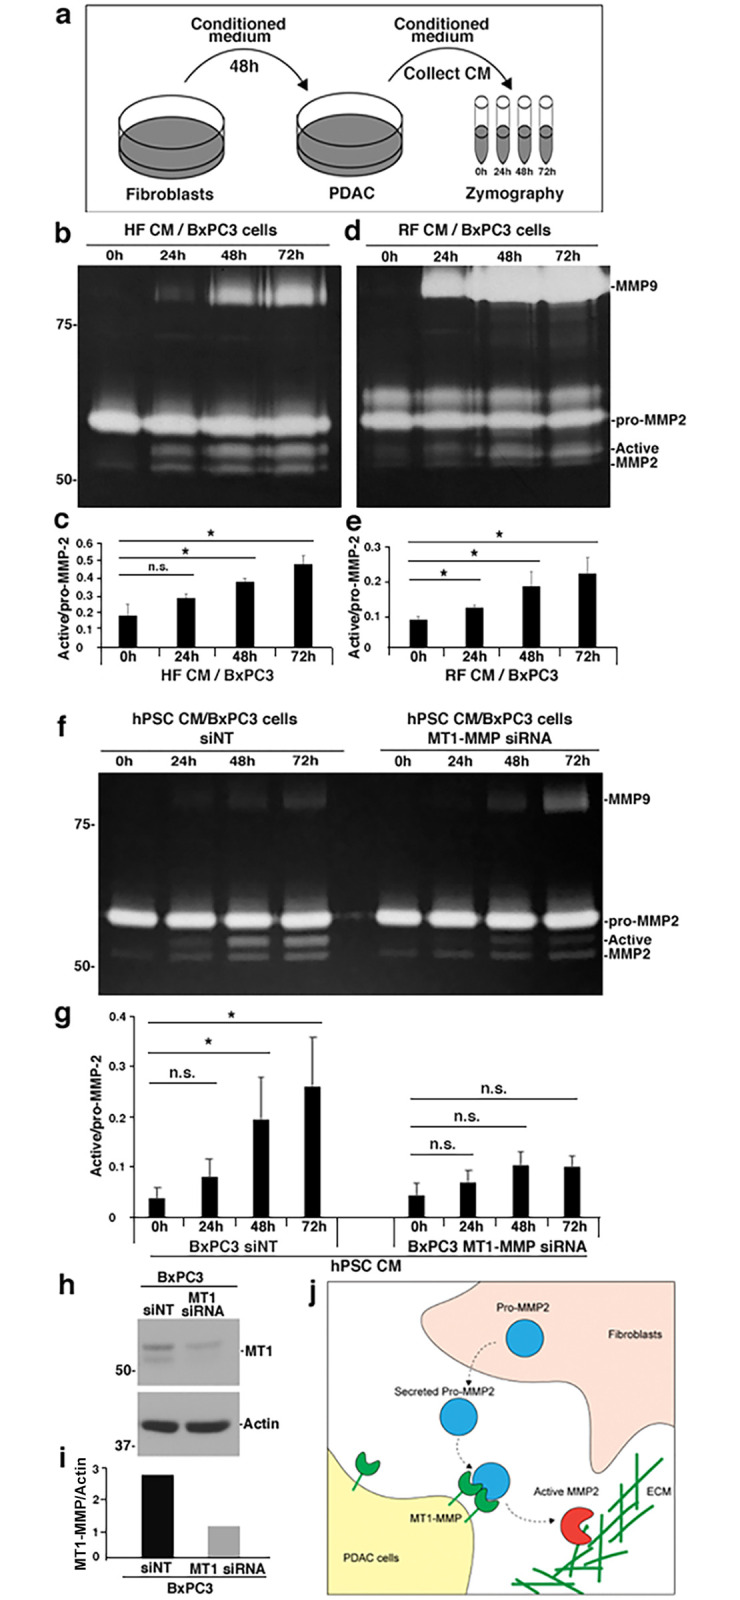
MMP2 secreted from stromal cells is activated by PDAC cell MT1-MMP.(a) An illustration of the experimental design followed for this experimental approach. CM from HFs, RFs, or hPSCs was collected and applied to BxPC3 cells. Subsequently, CM from the PDAC cell cultures was collected after 0, 24, 48 or 72 h and subjected to zymography. (b,d) Representative zymograms showing MMP2 activity of the CM described above. The activity of this protease from the HF CM (b) or RF CM (d) was increased by longer incubation times with BxPC3 cells. (c, e) Quantitative graphs depicting the ratio of pro/active MMP2 at each timepoint, demonstrating the increase in activity of MMP2 from the zymograms of at least 3 independent experiments. (f) MT1-MMP was depleted in BxPC3 cells by siRNA transfection. MMP2 in CM from hPSCs is also activated over time when incubated with control BxPC3 cells, but this is inhibited following MT1-MMP knockdown. (g) Quantitation of the ratio of pro/active MMP2 at each timepoint from zymograms from 3 independent experiments. Averages ± SEM. *p <0.05. **p <0.01. n.s, not statistically significant. (h-i) The knockdown of MT1-MMP was verified by western blot and quantified by normalizing MT1-MMP to actin. (j) Proposed model showing the functional relationship between tumor cell MT1-MMP and stromal cell MMP2 during matrix remodeling. MT1-MMP presented at the surface of PDAC tumor cells can cleave and activate the pro-MMP2 provided by fibroblasts. The result of this activation is enhanced matrix remodeling and increased cancer cell invasion.